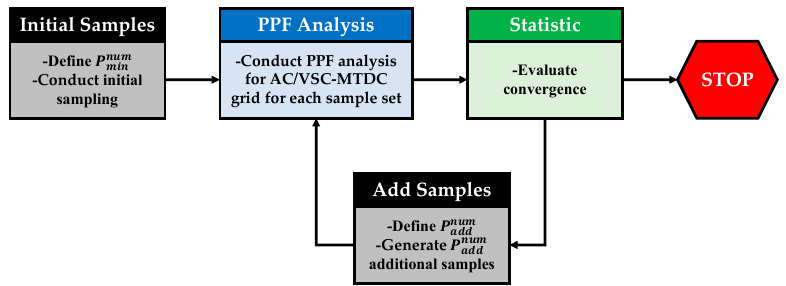
Figure 2. The schematic diagram of inherited Latin hypercube sampling (ILHS).